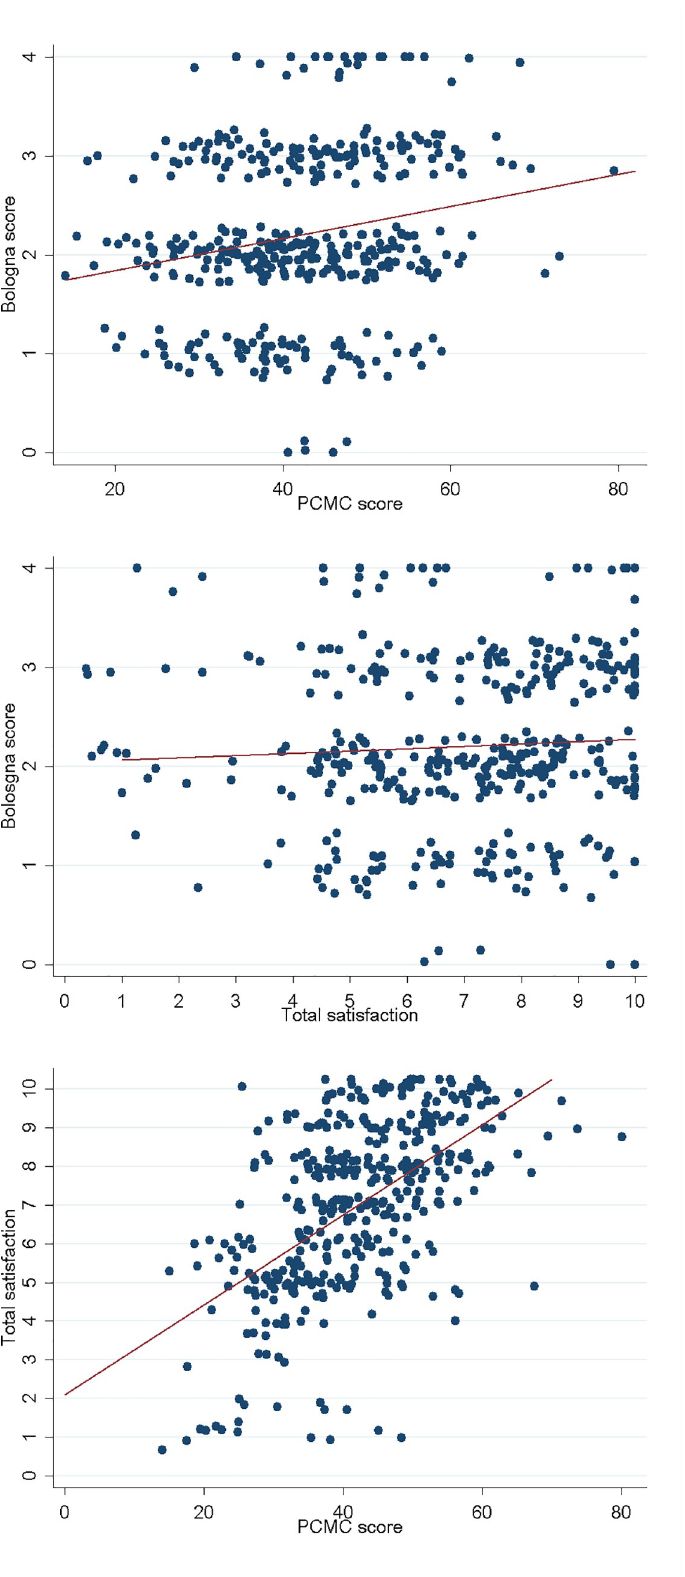
Fig 4. Correlation among different